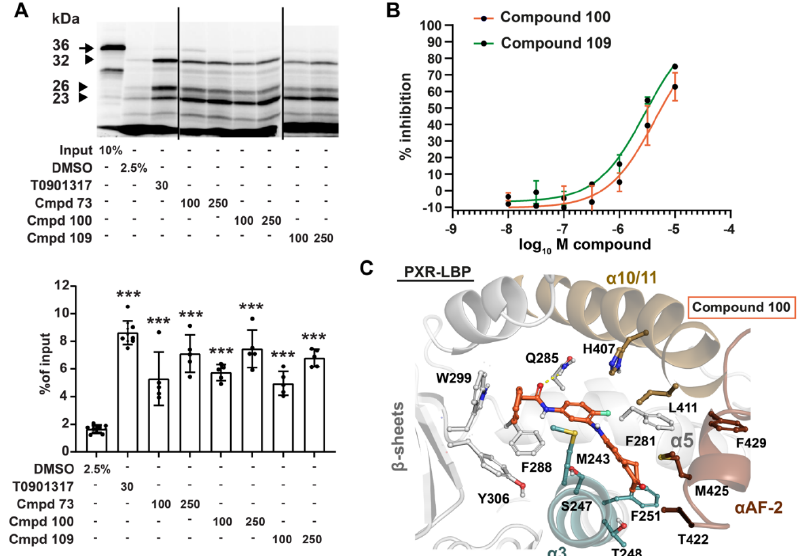
Figure 4. Phenylaminobenzosuberones demonstrate direct binding to PXR. ( A ) Limited proteolytic digestion assay was conducted by preincubating 35 S-labeled PXR LBD with 100 µM or 250 µM test compounds, 30 µM T0901317, or 2.5% DMSO. Upper panel shows the radioluminographic scan of a representative experiment. Arrow shows 36 kDa input of PXR LBD, and arrow heads show protected 32, 26, and 23 kDa fragments after limited proteolytic digest with trypsin. Lower panel shows respective densitometric quantifications of the sum of the three protected fragments. Columns show mean ± SD of five independent experiments (each performed as single measurement) and the individual experiments illustrated with dots, calculated with respect to input. Statistically significant differences are illustrated with asterisks. *** p ˂ 0.001, compared to respective preincubations with DMSO and analyzed by one-way ANOVA with Dunnett’s multiple comparisons test. ( B ) Competitive radioligand binding assay demonstrates direct binding of compounds 100 and 109 to PXR. Data are shown as means ± SD of % inhibition of control specific binding by test compounds from duplicate analysis. ( C ) Putative binding mode of compound 100 in the PXR-LBP. A representative snapshot taken from the microsecond timescale MD simulations [42] is shown in the figure, where compound 100 (orange C-atoms stick model) is shown with the closely located key residues of PXR-LBP (shown with sticks, with colors matching to their secondary structure region: α AF-2, dark brown; α 3-helix, cyan; α 10/11-helix, light brown; other, white). The benzyl moiety of 100 is occupying the hydrophobic subpocket formed by F288, W299, and Y306, while the benzosuberone is oriented toward the α AF-2 region. H-bond to Q285 from the amide is shown with yellow dashed line.